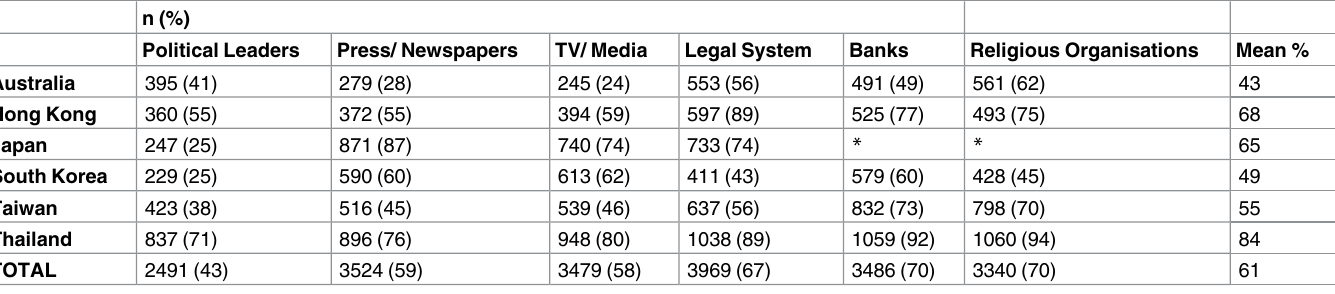
Table 1. Proportion of respondents indicating higher trust (trust ‘a little’ or ‘a lot’) in institutions. n (%) Political